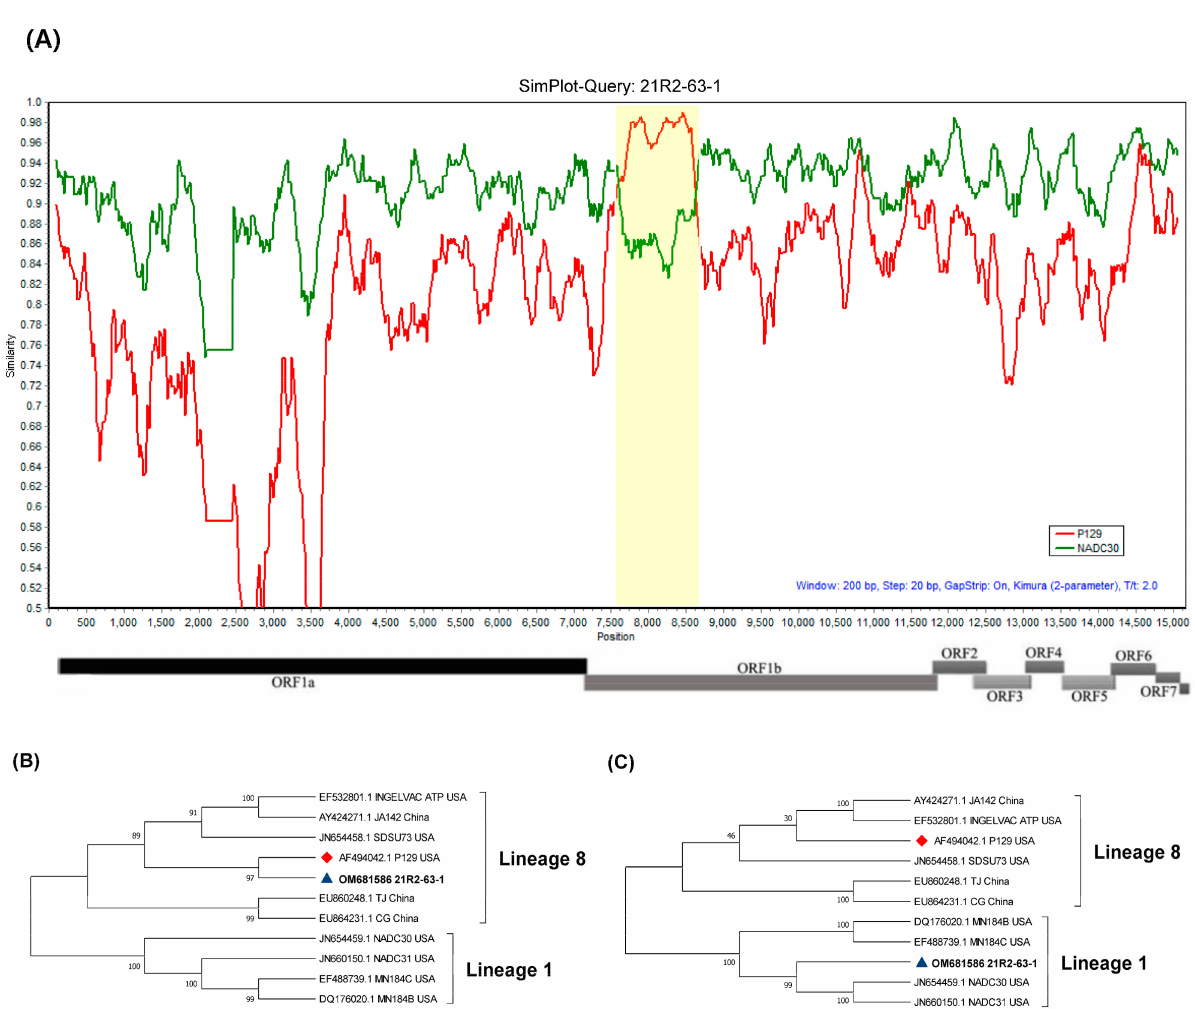
Figure 3. Recombination analyses of 21R2-63-1 and representative PRRSV lineages. ( A ) Similarity plot and bootscan analyses of 21R2-63-1 using Simplot. Yellow indicates the recombination region between 7654 and 8599 within ORF1b. The y -axis indicates the percentage similarity between the parental sequences and the query sequences. Phylogenetic trees of minor ( B ) and major ( C ) regions. The minor parental region of 21R2-63-1 was found to be related to the P129 strain, but the major parental region of 21R2-63-1 was closely related to NADC30 strain. 21R2-63-1 is indicated by a blue ▲ ), and vaccine strains are indicated by a red diamond ( ◆